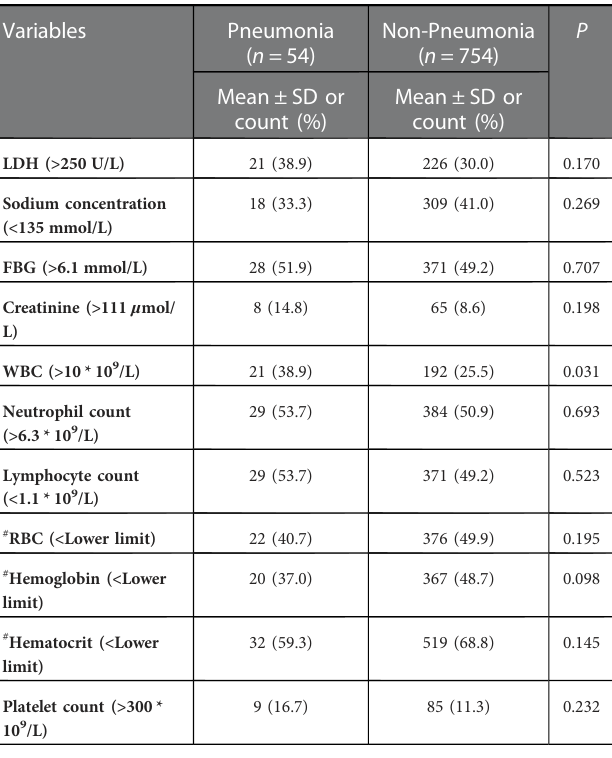
SD, standard deviation; BMI, body mass index; ASA, american society of anesthesiologists; WBC, white blood cell; A/G, albumin/globulin; HCRP, hypersensitive c-reactive protein; LDH, lactate dehydrogenase; FBG, fasting blood glucose; RBC, red blood cell.